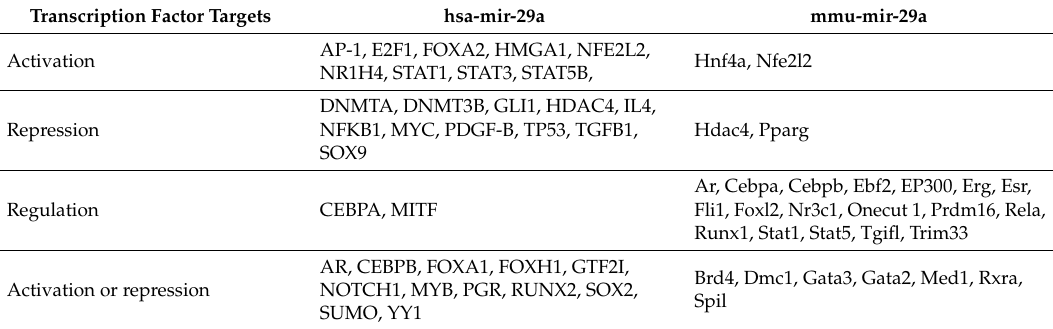
Table 1. Putative transcription factor targets of human and murine